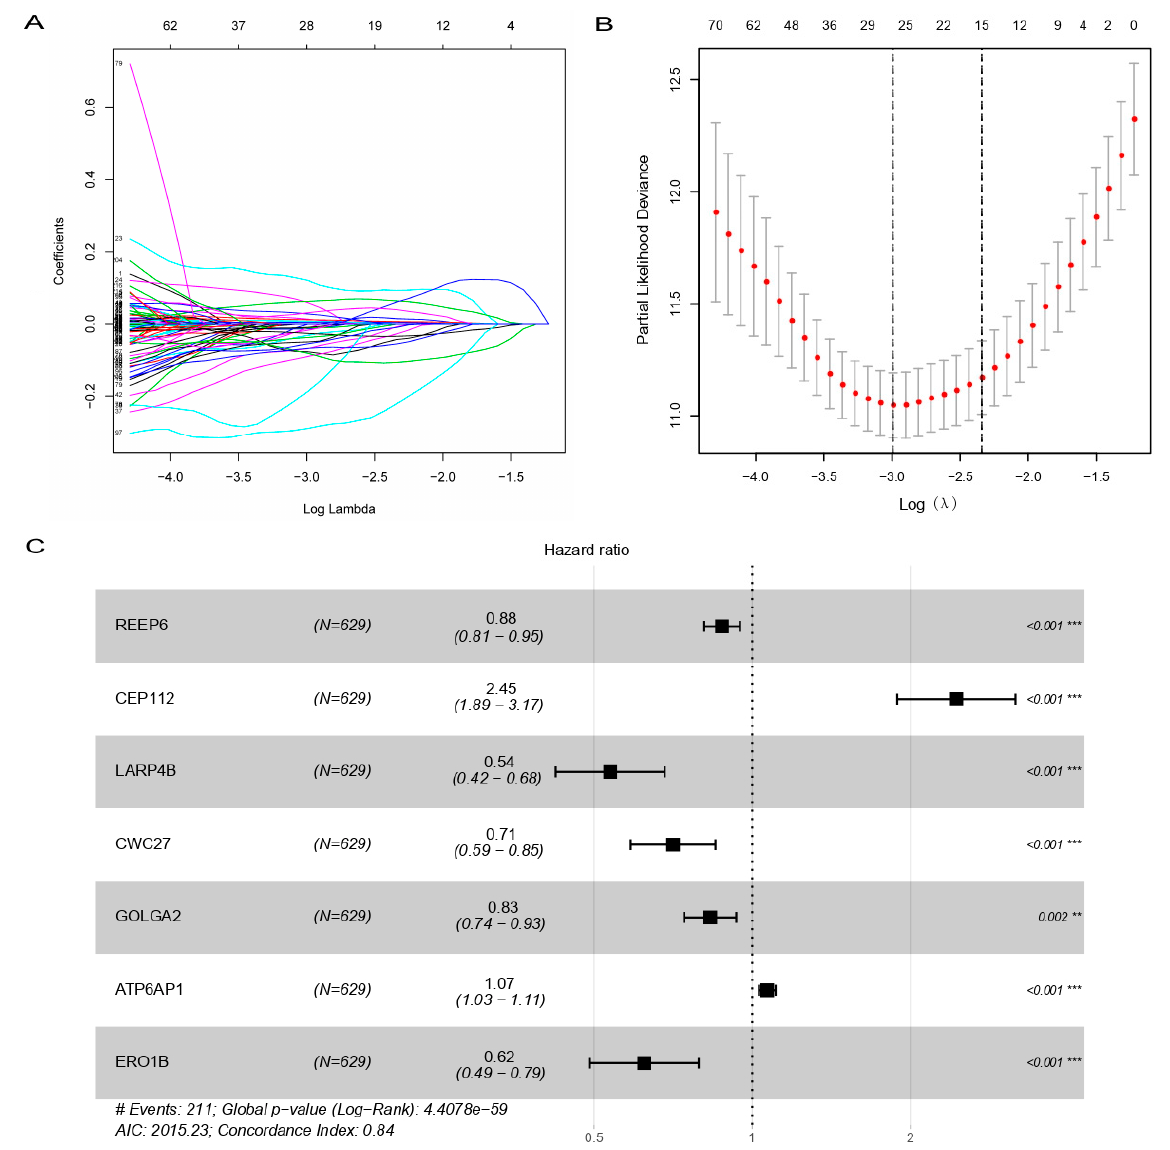
Figure 2. Final acquisition of prognostic DEGs for developing a risk model in TCGA cohort. ( A ) LASSO coefficient profiles of SARS-Cov-2 related genes. ( B ) Partial likelihood deviance of different numbers of variables revealed by the LASSO regression model (The log( λ ) sequence plot of SARS-Cov-2 related genes using LASSO regression). ( C ) Forest plot of SARS-Cov-2-related genes. DEGs, differentially expressed genes; LASSO, least absolute shrinkage, and selection operator. ** p < 0.01, *** p <